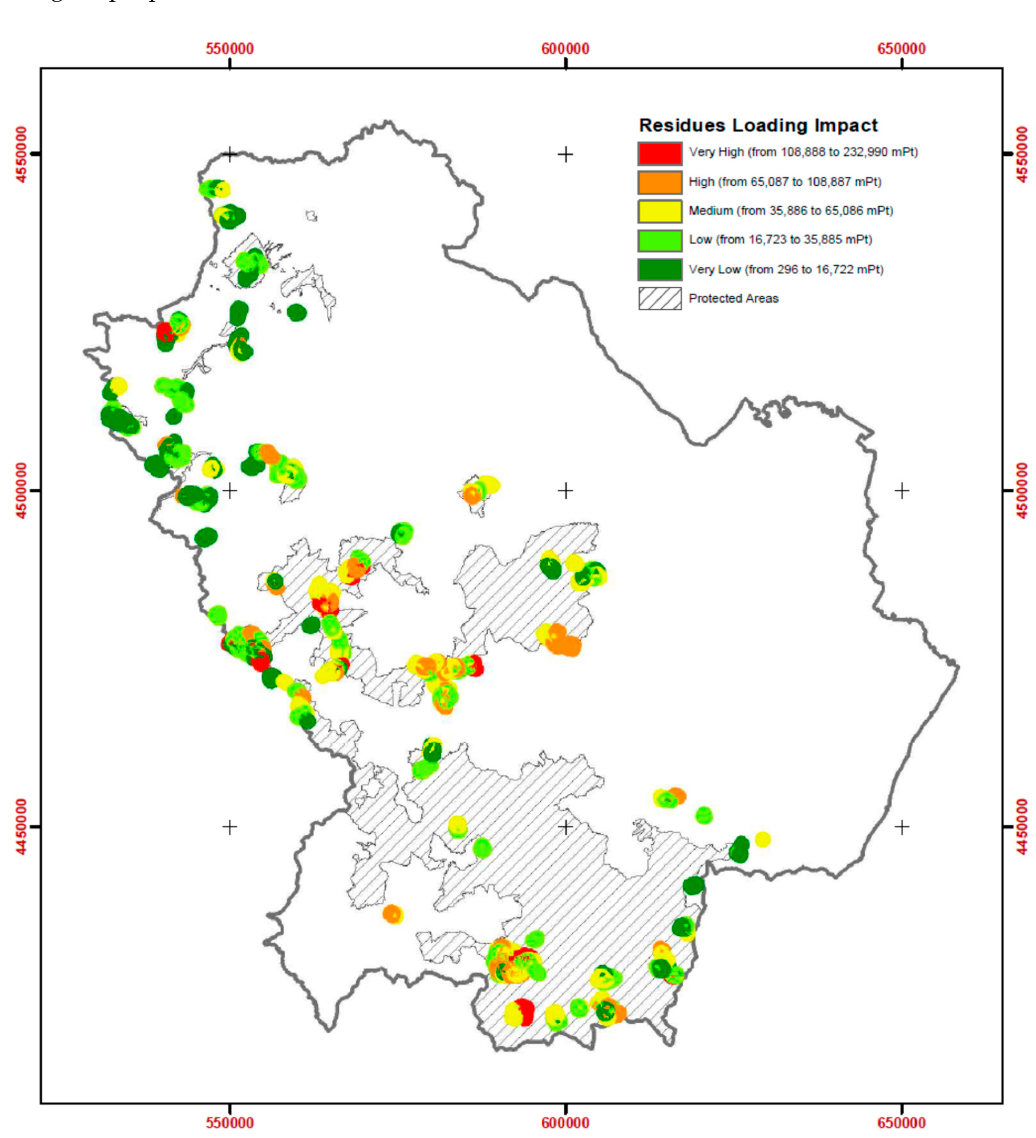
Figure 2. Regional distribution of harvesting residues and relative load impacts per impact class.